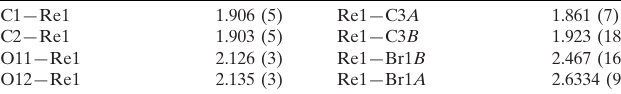
Selected bond lengths (A˚ ).